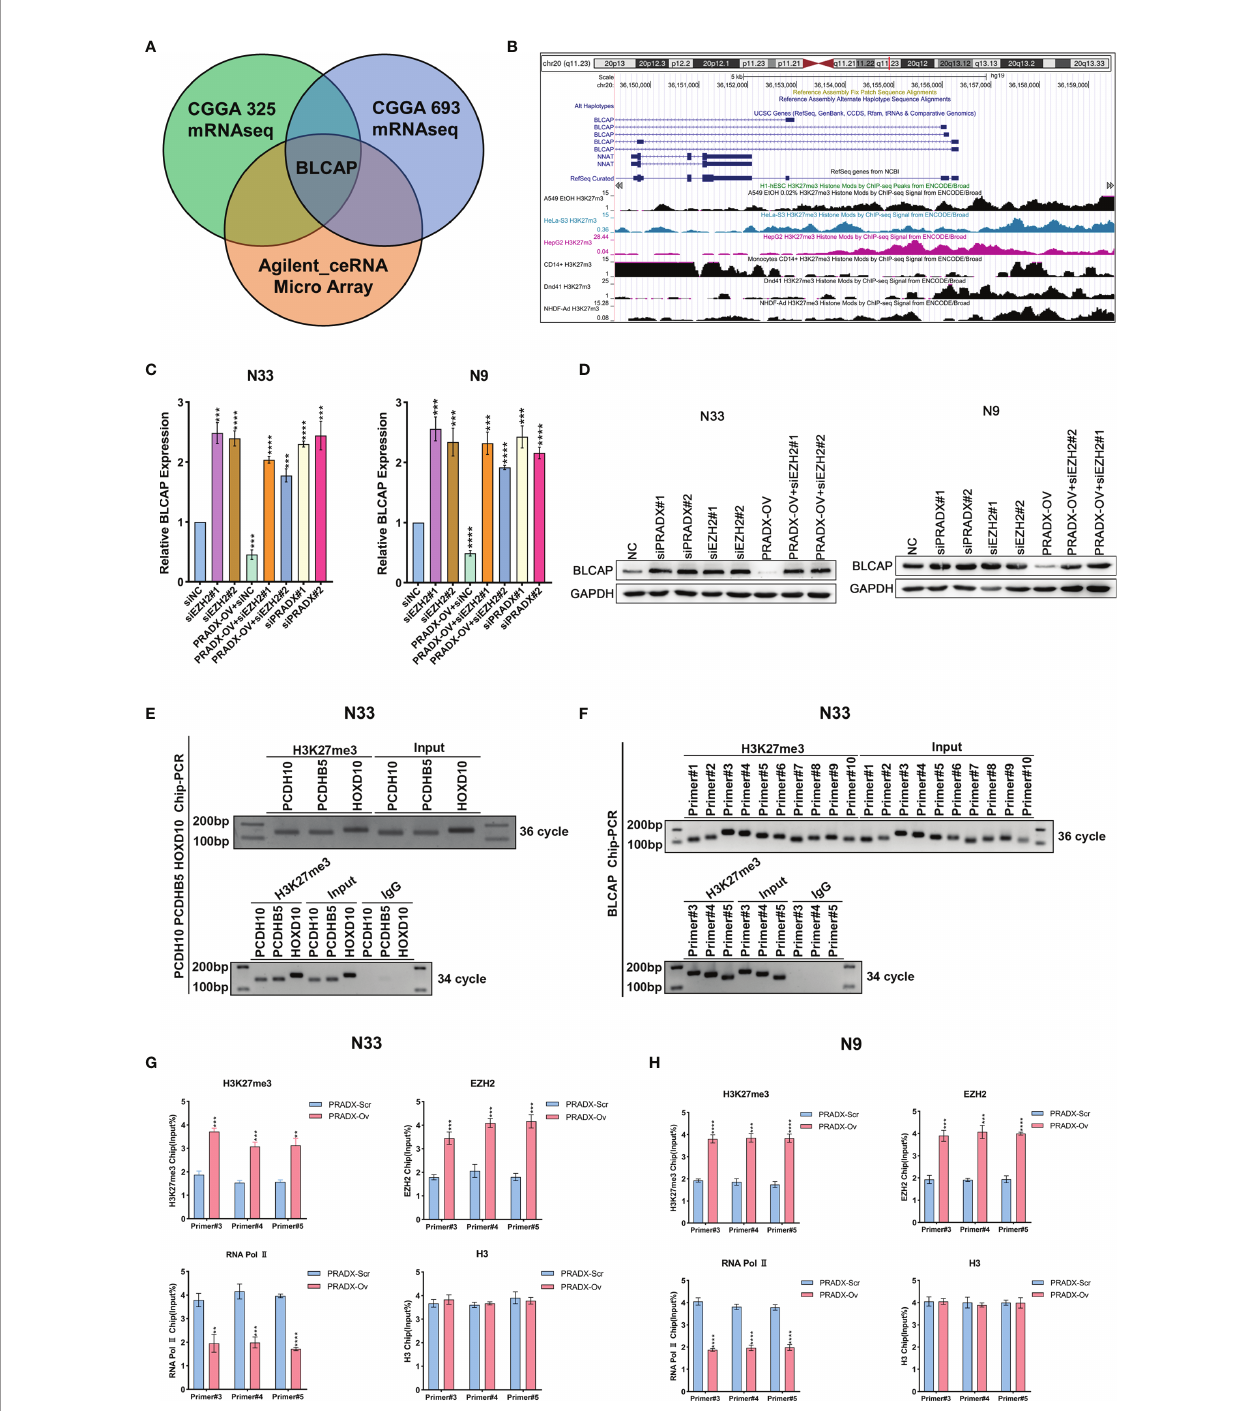
FIGURE 3 | The interaction of PRADX and EZH2 silences BLCAP expression via recruiting H3K27me3 at the BLCAP promoter. (A) BLCAP was the most negatively correlated TSG with PRADX in the CGGA database and Agilent ceRNA microarray analysis. (B) H3K27me3 binding peaks on the BLCAP promoter region in different cell lines as per the UCSC webtool. (C, D) qRT-PCR and western blotting analyses revealing BLCAP expressions after PRADX overexpression or EZH2 siRNA treatment. (E) Application of the ChIP primers of the three TSGs reported in the literature to verify the target protein binding at the chromatin level. (F) ChIP-PCR showed H3K27me3 enrichment at the BLCAP promoter region. (G, H) ChIP-qPCR exhibits the occupancy levels of H3K27me3, EZH2, RNA polymerase II, and H3 at the BLCAP promoter region in scrambled and PRADX overexpressed cells. The values in (C, G, H) are represented as mean ± SD (n = 3). **P < 0.01, ***P < 0.001, ****P